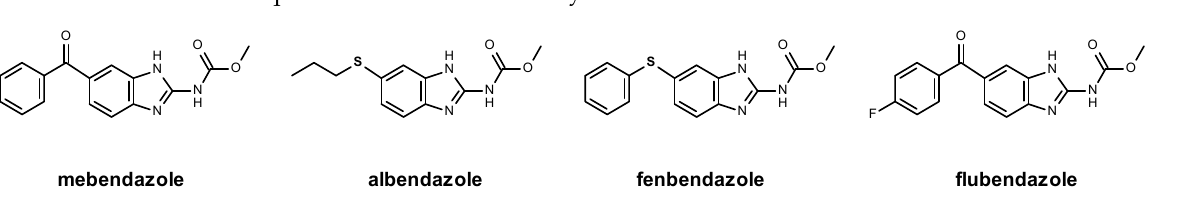
Figure 1. Chemical structures of benzimidazole derivatives.